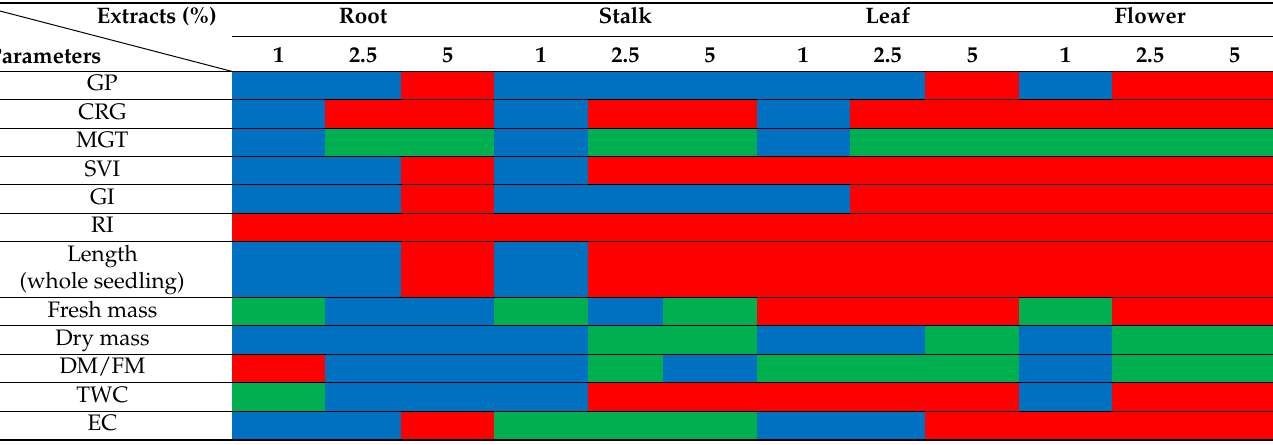
Table 4. Comparison of the studied germination and growth parameters of Raphanus sativus L. var. radicula Pers. cv. Rowa seedlings grown on the aqueous extracts from the organs of Rosa blanda Aiton with different percentage concentrations (1%, 2.5%,